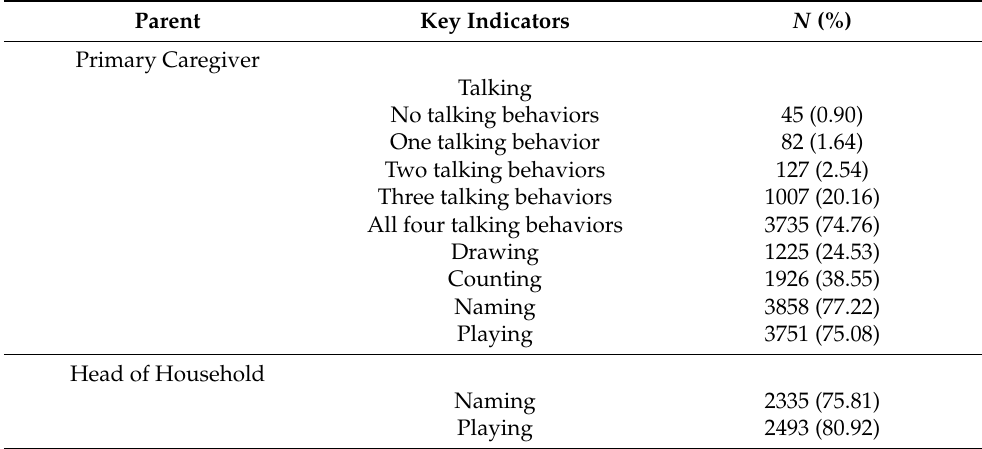
Table 3. Participants Reporting Practice of Key Early Childhood Development Behaviors.